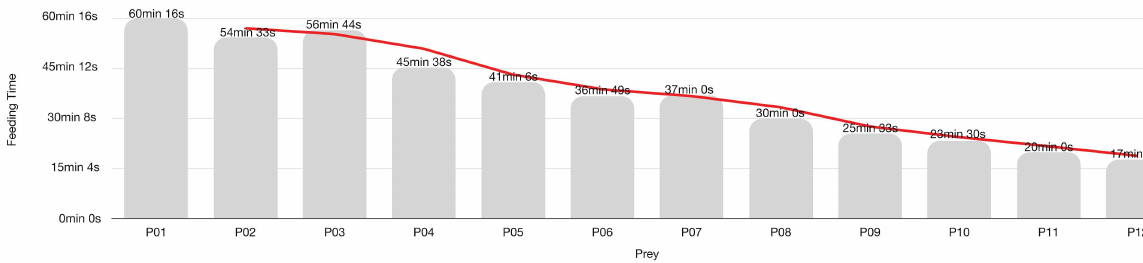
Figure 14. LAB male feeding on Bactrocera oleae adult.